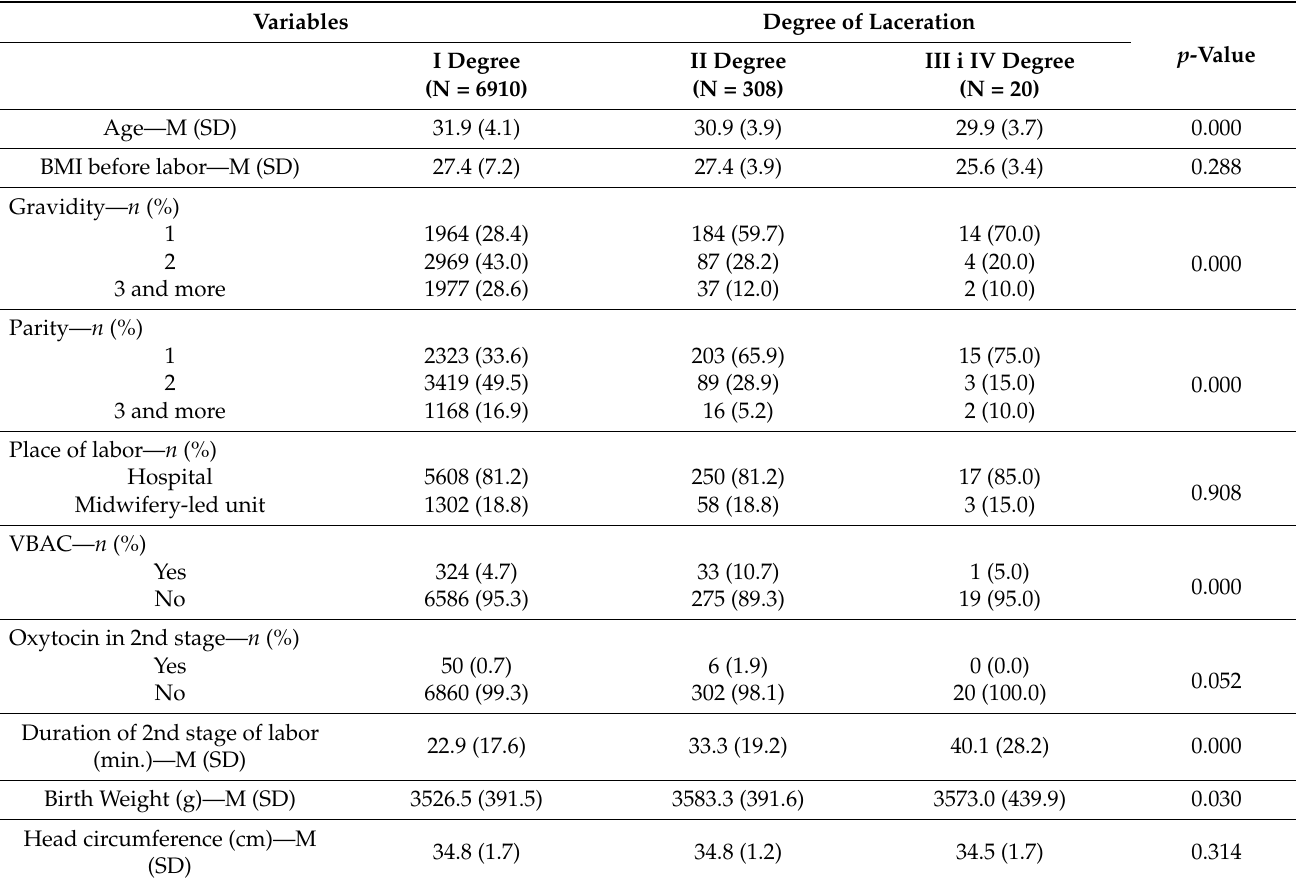
Table 3. Analysis of the relationship between the degree of perineal laceration and selected variables.